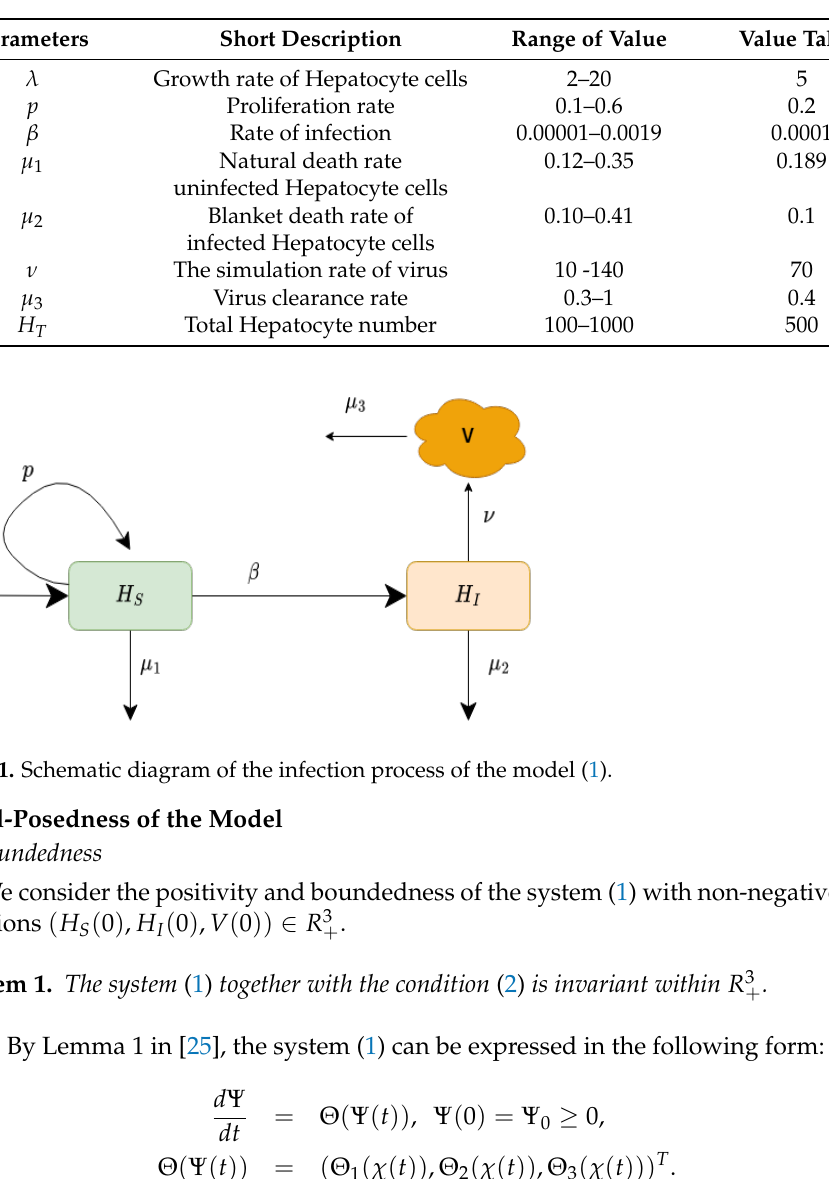
Table 1. List of parameters for the model (1).